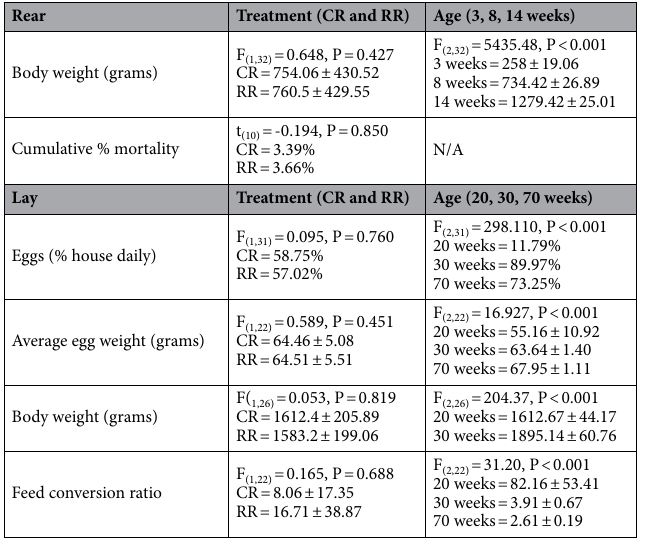
Table 4. Production data statistical analysis for control reared (CR) and ramp reared (RR) flocks at rear (3, 8, 14 weeks of age) and at lay (20, 30 and 70 weeks of age), raw means ±